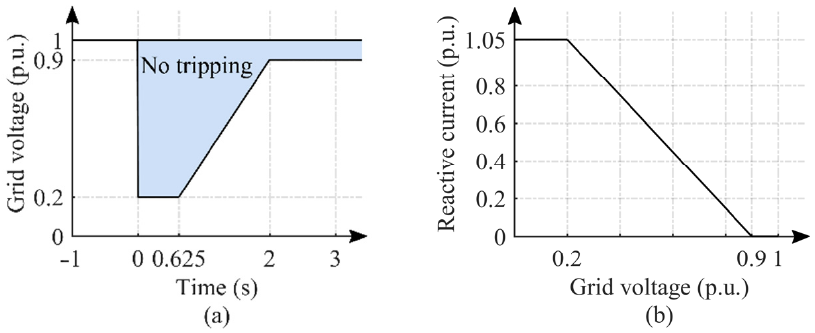
Figure 1. LVRT requirements ( a ) Continuous operation area. ( b ) Reactive current.